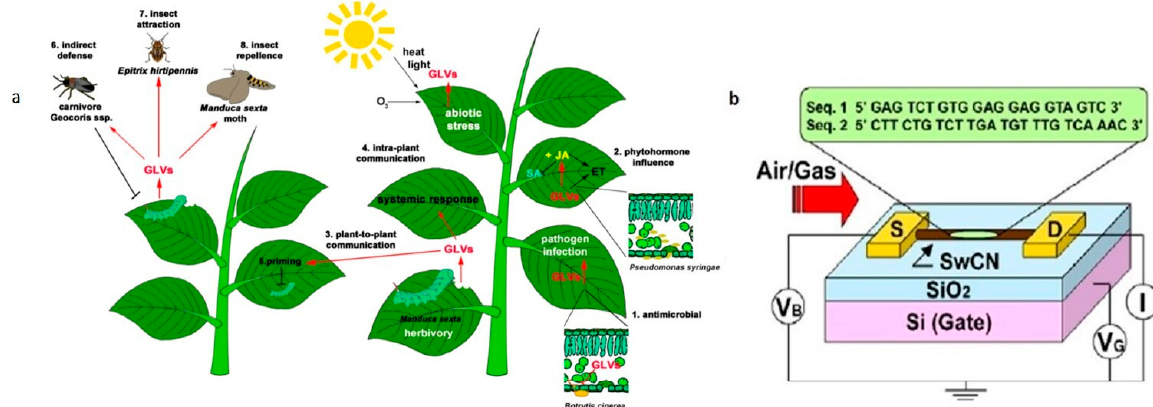
Figure 4. ( a ) Schematic representation of green leaf volatiles (GLVs) emission during herbivory, pathogen infection, and abiotic stress (reproduced with permission from [53], licensed under the Creative Commons Attribution). ( b ) Illustration of the experimental setup made by single-stranded DNA (ss-DNA) and single-walled carbon nanotube field effect transistors (swCN-FETs) (reproduced from [74] with